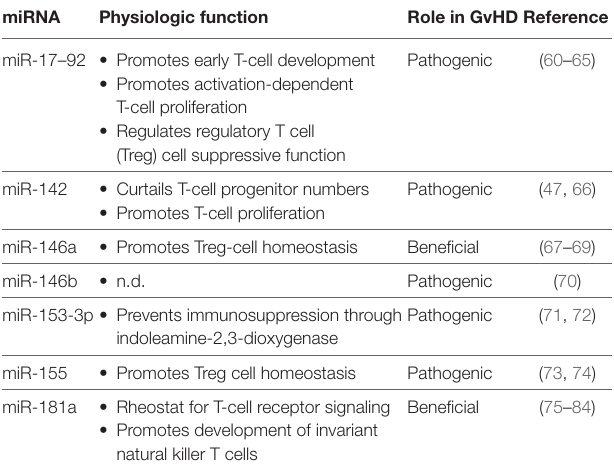
TAbLe 1 | MicroRNAs (miRNAs) acting in T cells, for which a role in graft- versus-host disease (GvHD) has been established in preclinical models. miRnA Physiologic function Role in GvHD Reference